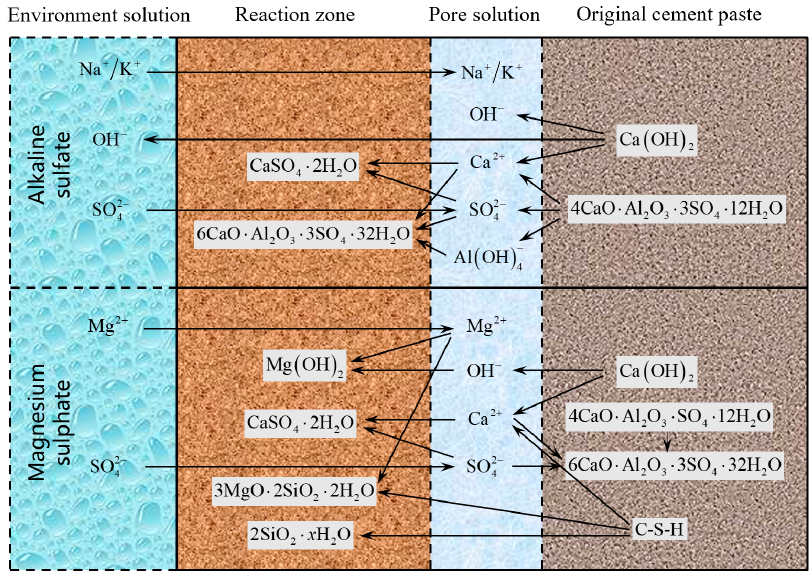
Figure 2. Chemical reactions in concrete under different cation sulfates [30].